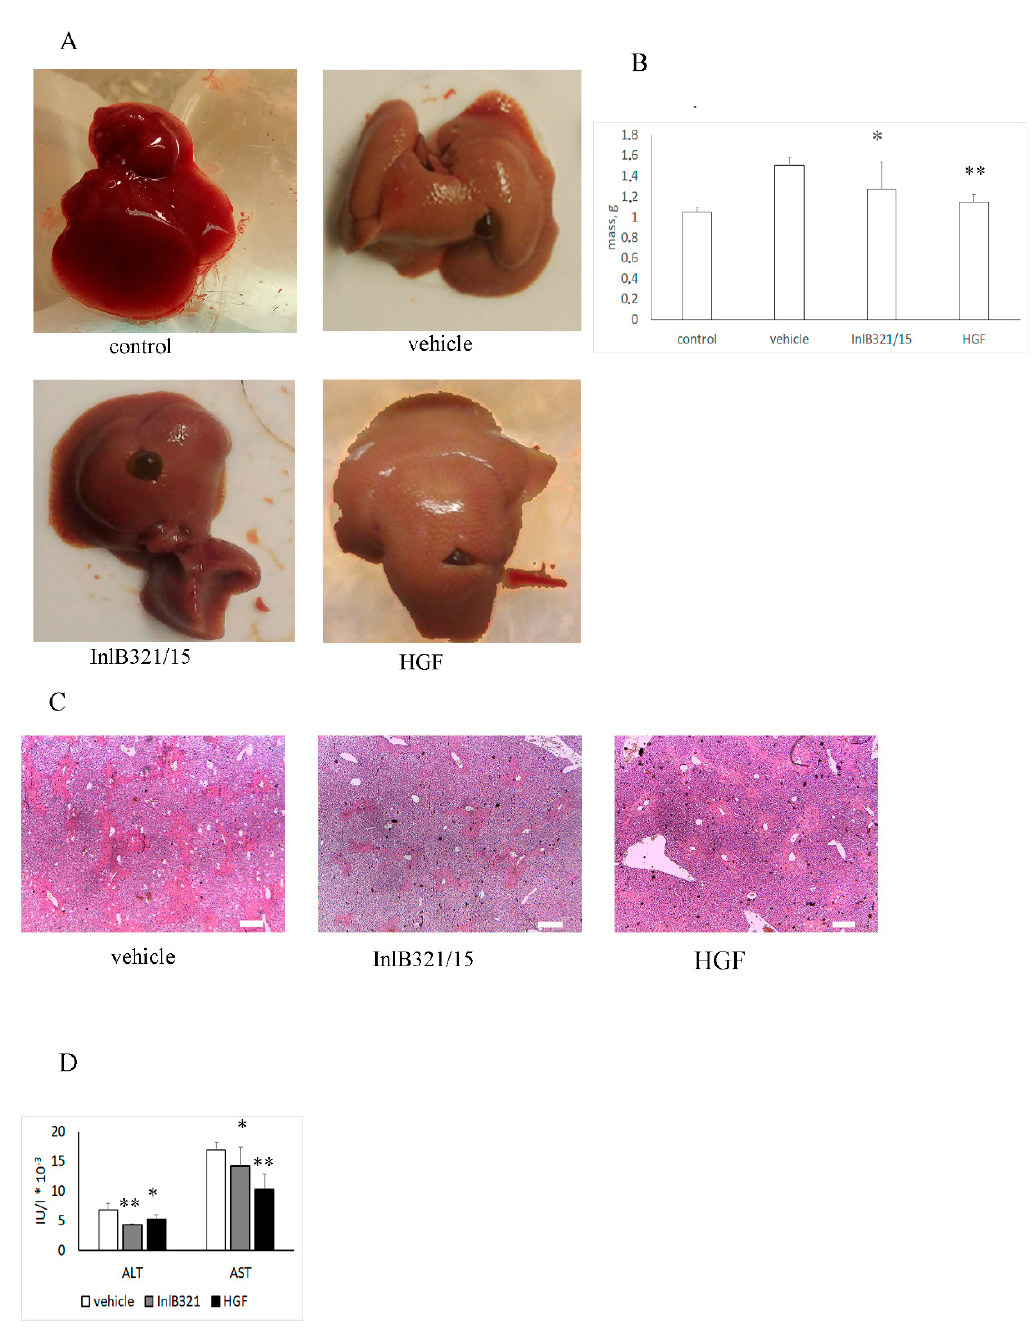
Figure 3. InlB321 / 15 provides a hepatoprotective effect. Mice received CCl4 intragastrically. A dose of 2 ng · g − 1 InlB321 / 15 or 2 ng · g − 1 rhHGF was injected intravenously 2 h before liver injury. The liver was extracted 48 h post liver injury. ( A ) Macroscopic changes in the liver; ( B ) changes in liver mass; ( C ) histopathologic changes in the liver; scale bar 250 µ m; ( D ) amino transferase (ALT) and aspartate amino transferase (AST) accumulation in the serum. Data represent mean values ± SD; * p < 0.05, ** p < 0.01.